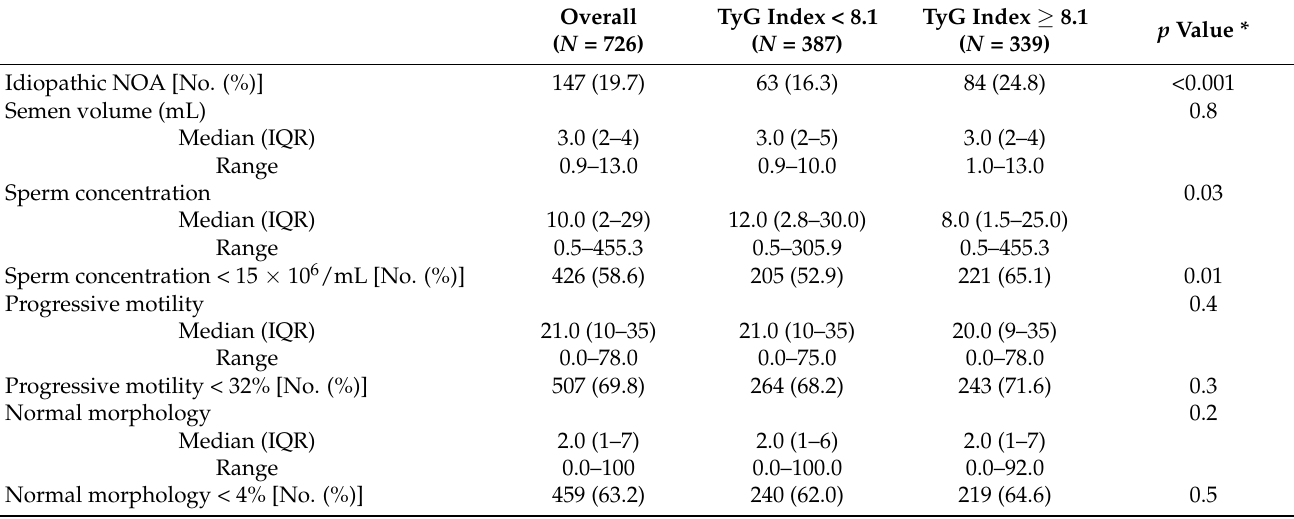
Table 3. Seminal parameters of the study cohort according to TyG index suggesting insulin resistance ( N =